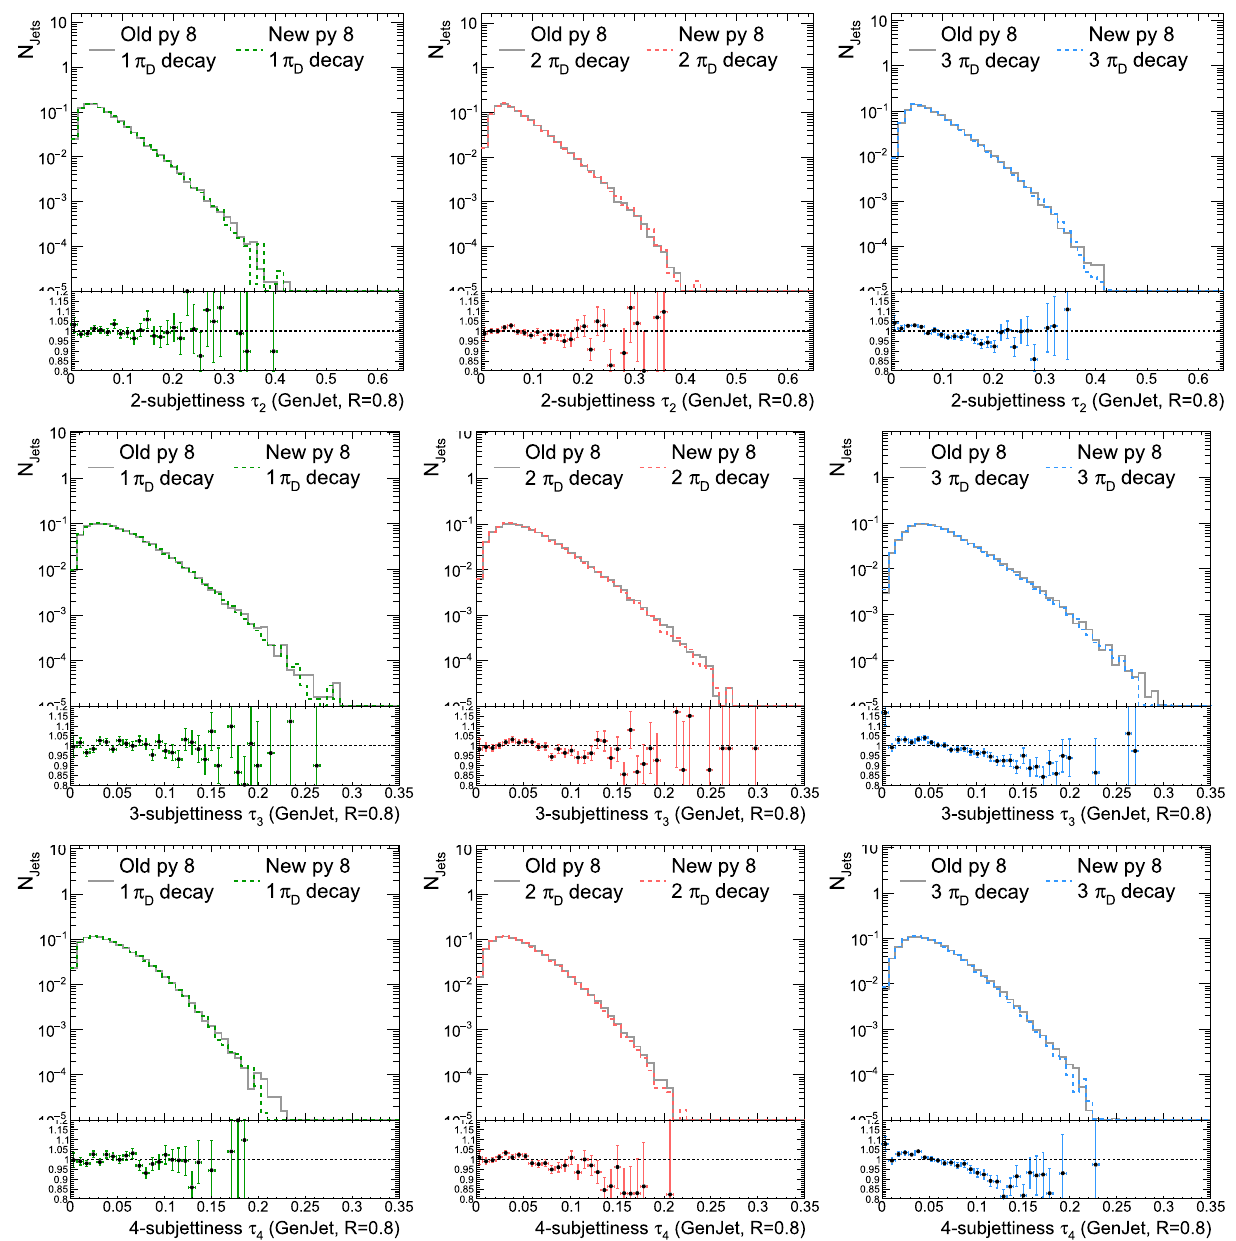
Fig. 40 Comparisonof N -subjettinessvariablesbetweenold(greysolidline)andnew(coloreddashedline)HiddenValleymodules.Thecomparison is made for 1 (left), 2 (middle) and 3 (right) dark pions decay. The plotted ratio is the ratio of new to old pythia module (cid:2) D these observables are correctly described by the